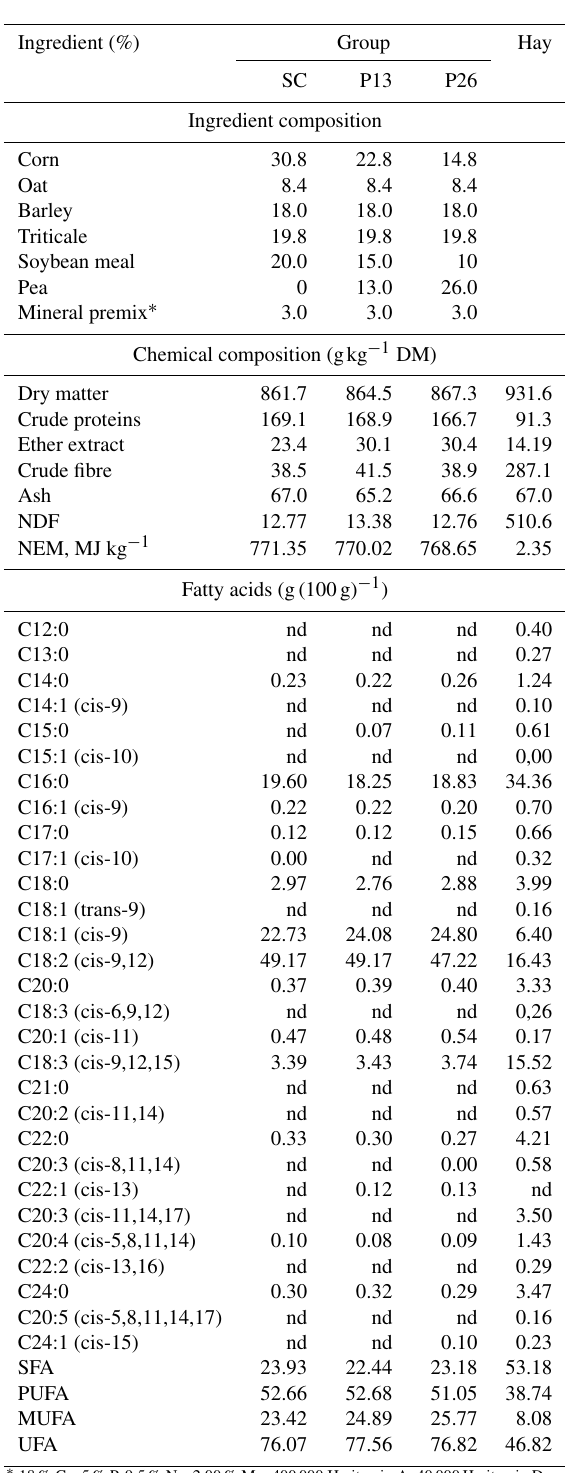
Table 1. Ingredient and chemical composition of the feed mixture and meadow hay for lambs’